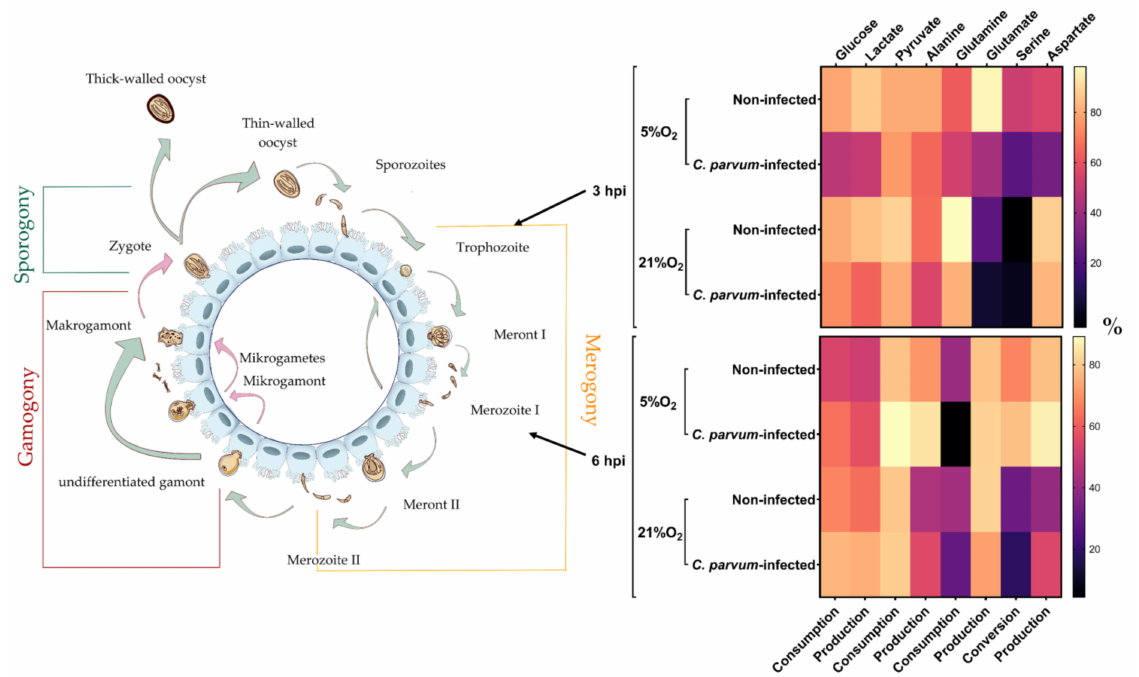
Figure 3. Conversion rates of key metabolites (glucose, lactate, pyruvate, alanine, glutamine, glutamate, serine, and aspartate) in supernatants of C. parvum -infected and non-infected bovine small intestinal (BSI) explants within the early phase of the parasitic life cycle. Metabolite conversion rates were analysed at 3 and 6 hpi under physioxic (5% O 2 ) and hyperoxic (21% O 2 ) conditions. Heatmaps present metabolic conversion rates as the mean ( n = 3) of normalized percentages (legend on the right) across the two analysed oxygen concentrations and timepoints post-infection. Serine conversion represents consumption at 5% O 2 3 hpi and 6 hpi, while at 21% O 2 3 hpi and 6 hpi serine was also partially produced. Metabolic conversion rates scale from low (dark) to high